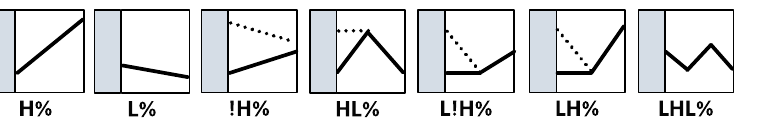
Figure 12. Schematic representation of boundary tones found in the data (the dotted line indicates alternative pitch tracks) (Pešková 2020). alternative pitch tracks) (Peškov á